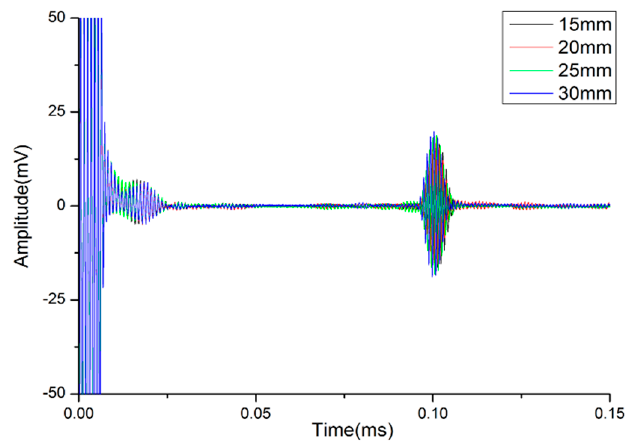
Figure 14. The reception signals of waveguide bars (No. 3–No. 6).